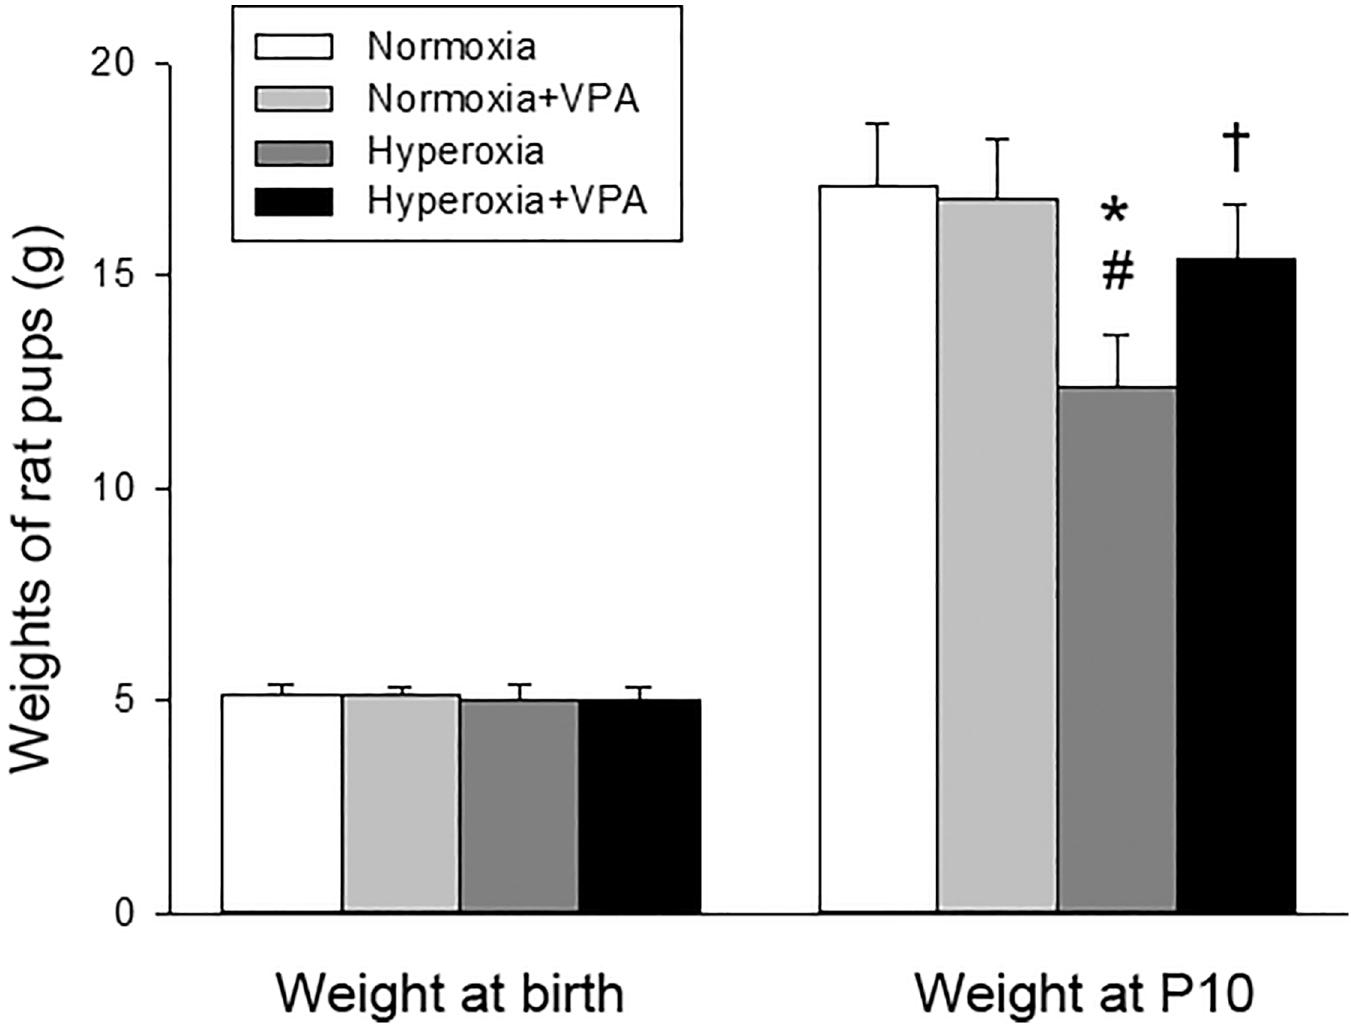
Fig 2. Bar graph depicting body weights of rat pups at birth and P10. * p < 0.05 compared to Normoxia group; #p < 0.05 compared to Normoxia+VPA group; and † p < 0.05 compared to Hyperoxia group using One-Way ANOVA followed by post-hoc Tukey